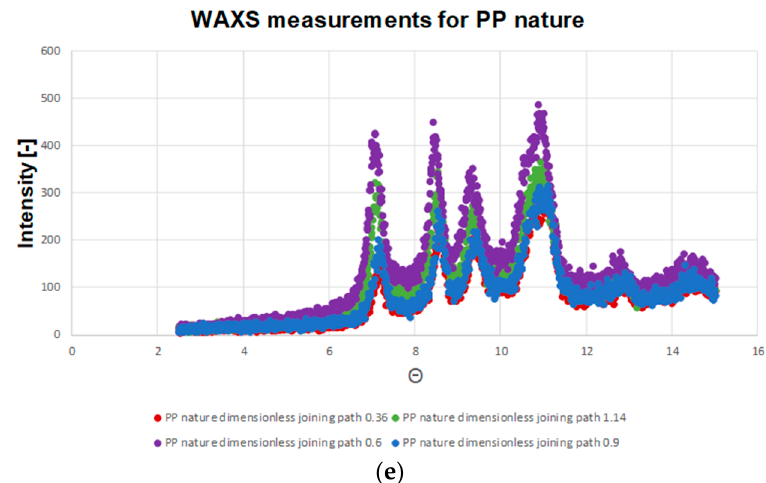
Figure 5. Microstructures of the welded PP nature with dimensionless joining path ( a ): 0.3; ( b ): 0.5; ( c ): 0.75; ( d ): 0.95; ( e ): WAXS measurement results of the welded PP nature for different joining paths. ● α -structure ● β -structure.